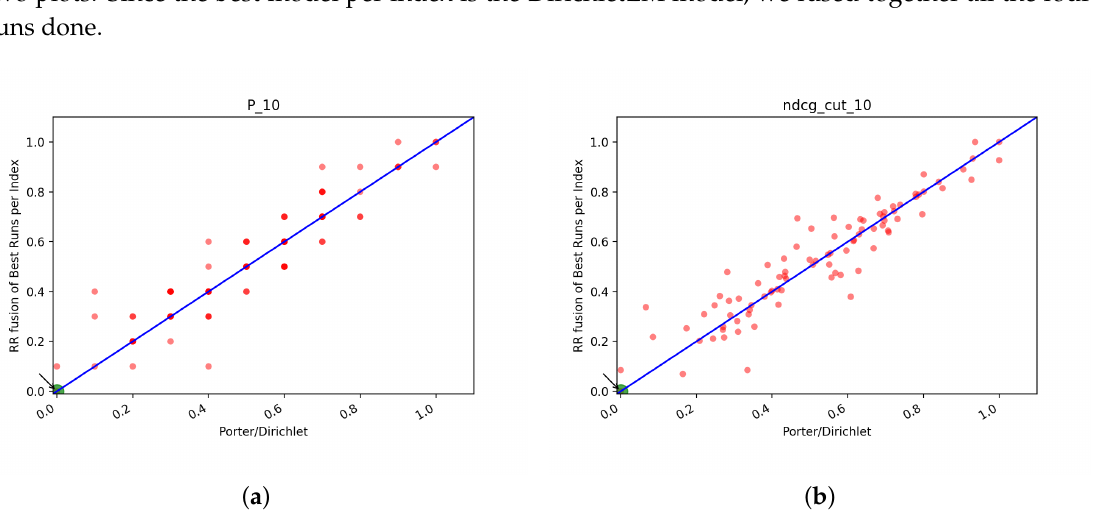
Figure 22. T2: scatter plots of P@10 and NDCG@10 of Porter/DirichletLM vs. RR fusion of best runs per index with QE+RF: ( a ) P@10, ( b )